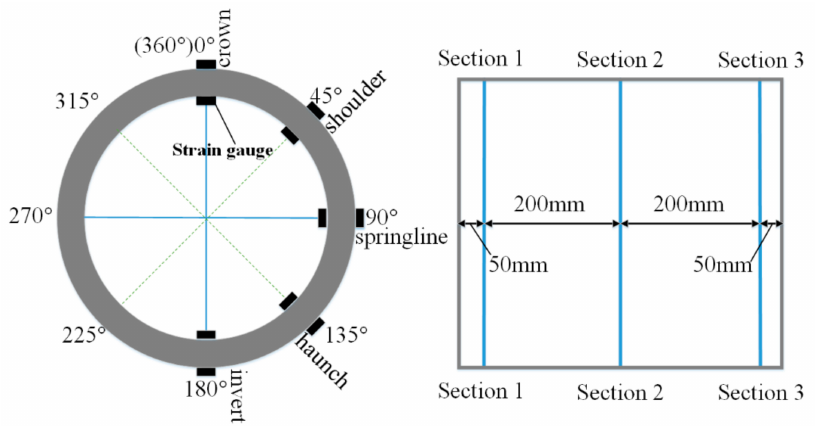
Figure 6. Layout of strain